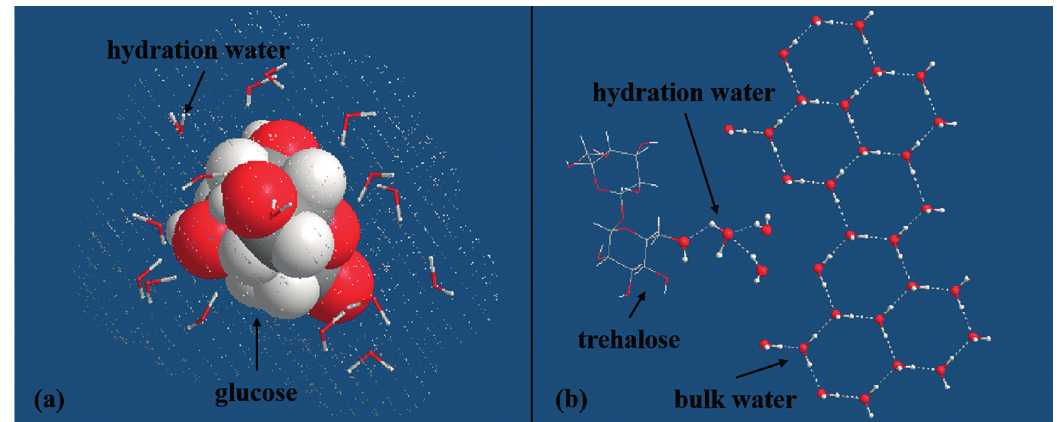
Figure 9. ( a ) Schematic of glucose and the first hydration layer consisting of 15 water molecules, as inferred from Lupi et al. [140]; ( b ) Schematic arrangement of many ordered bulk water molecules and two hydration layers controlled by trehalose, as inferred from Sajadi et al.